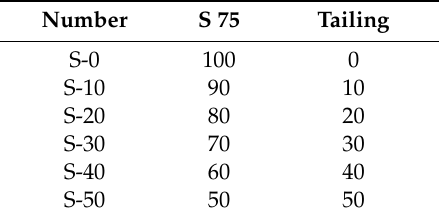
Table 8. Composite admixture proportions / wt %.